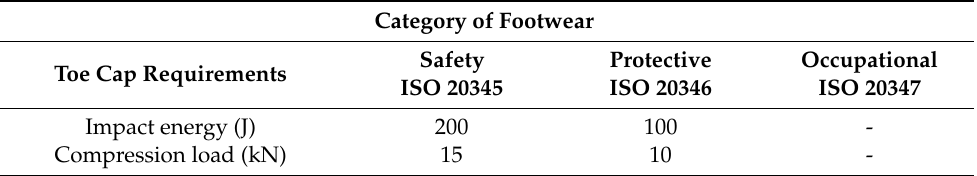
Table 1. Mechanical requirements for each type of protective footwear